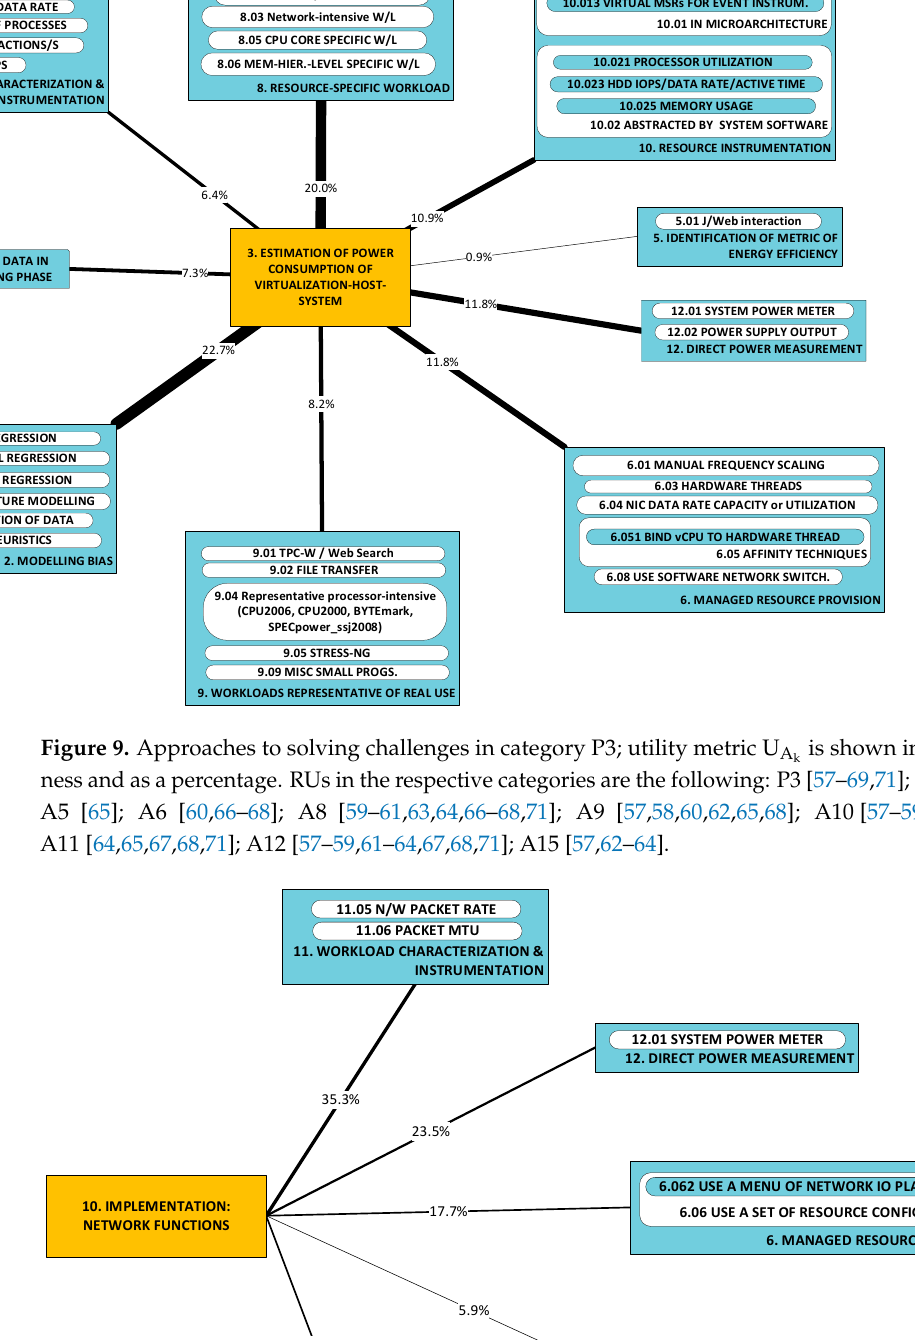
is shown in line k